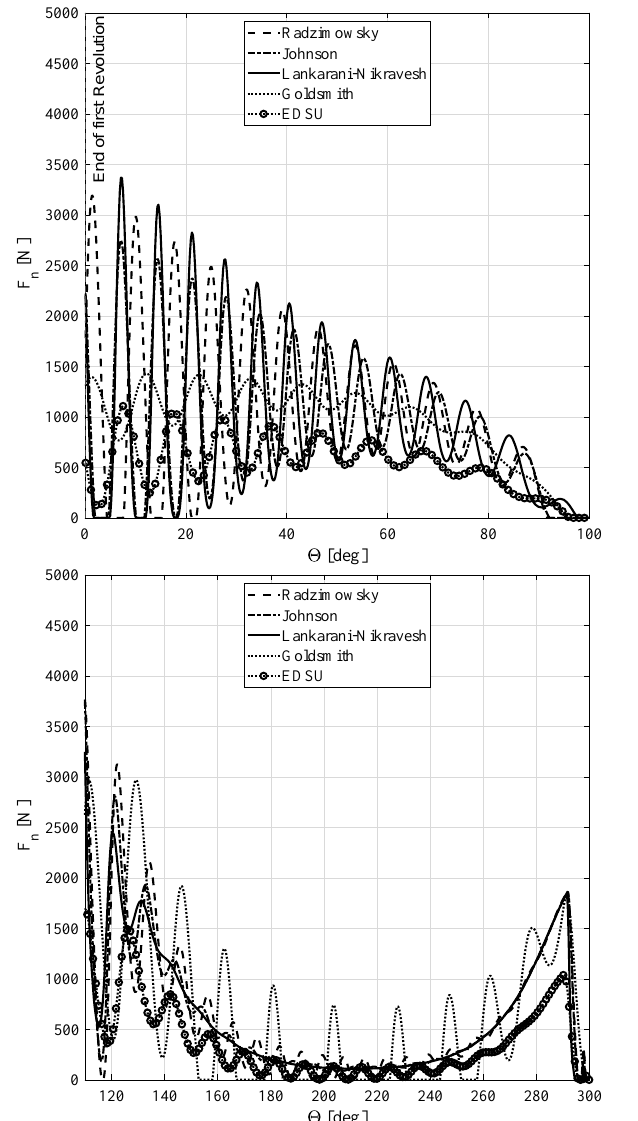
Figure 14. Detail of contact force